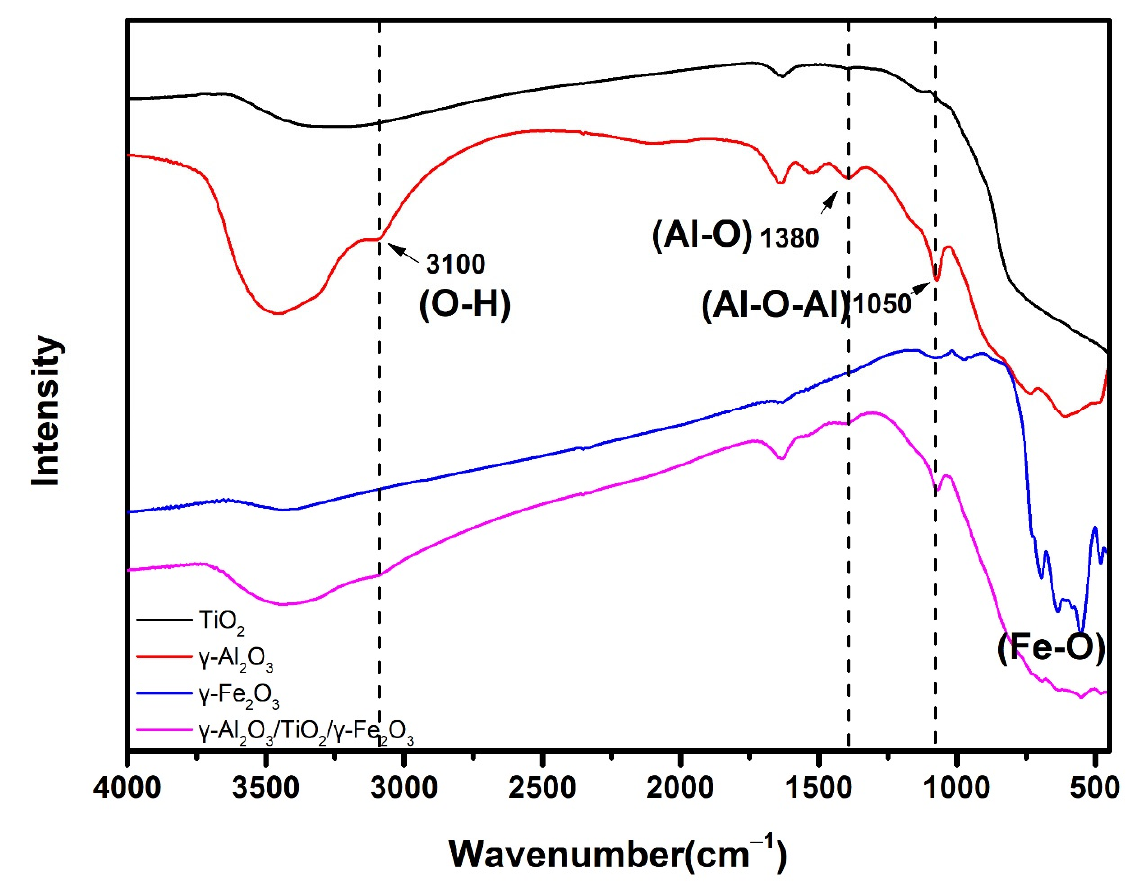
Figure 4. FT-IR spectra of γ -Al 2 O 3 /TiO 2 / γ -Fe 2 O 3 , TiO 2 , γ -Fe 2 O 3 , and γ -Al 2 O 3 .